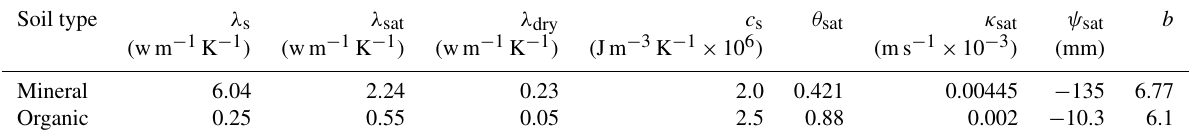
Table 1. Noah-MP parameterization options used in this study. Parameterization description Options Dynamic vegetation 4: table LAI, shdfac = maximum Stomatal resistance 1: BALL-Berry (Ball et al., 1987) Soil moisture factor for stomatal resistance 1: original Noah (Chen and Dudhia, 2001) Runoff/soil lower boundary 2: TOPMODEL with equilibrium water table (Niu et al., 2005) Surface layer drag coefficient calculation 1: Monin–Obukhov (Brutsaert, 1982) Supercooled liquid water 1: no iteration (Niu and Yang, 2006) Soil permeability 1: linear effects, more permeable (Niu and Yang, 2006) Radiative transfer 3: two-stream applied to vegetated fraction Ground surface albedo 2: CLASS (Verseghy, 1991) Precipitation partitioning between snow and rain 1: Jordan (Jordan, 1991) Soil temp lower boundary 2: TBOT at ZBOT (8m) read from a file Snow/soil temperature time 1: semi-implicit Table 2. Soil parameters used in Noah-MP for mineral soil texture classes (sandy clay loam) and organic soil (Hemic Peat). Soil type λ s λ sat λ dry c s θ sat κ sat ψ sat b Mineral Organic 0.25 The soil parameters are as follows: λ s is the thermal conductivity of soil solids, λ sat is the unfrozen saturated thermal conductivity, λ dry is the dry soil thermal conductivity, c s is the soil solid heat capacity, θ sat is the saturated volumetric water content (porosity), κ sat is the saturate hydraulic conductivity, ψ sat is the saturated matric potential, and b is the Clapp and Hornberger